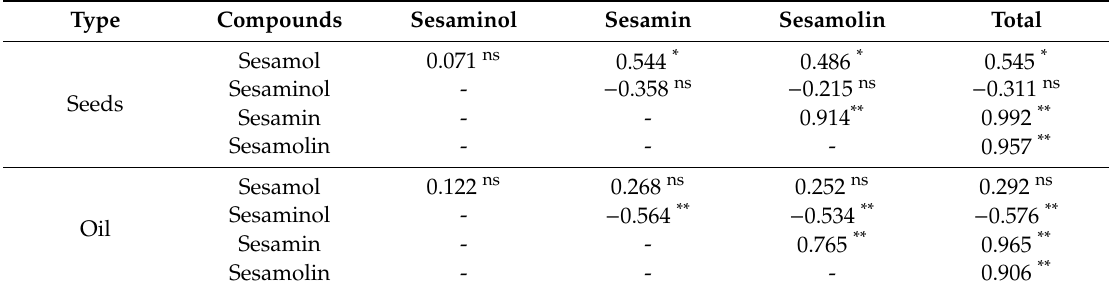
Table 4. Pearson correlation between compounds of sesame seeds and